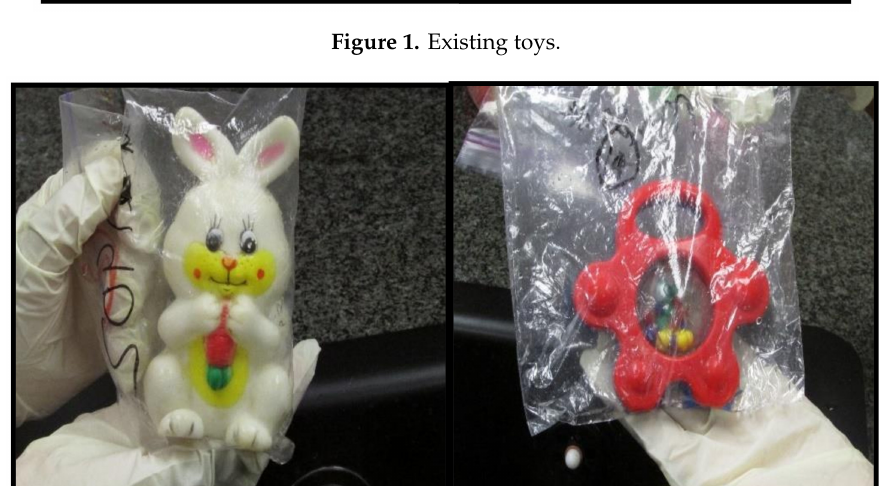
Figure 2. Introduced